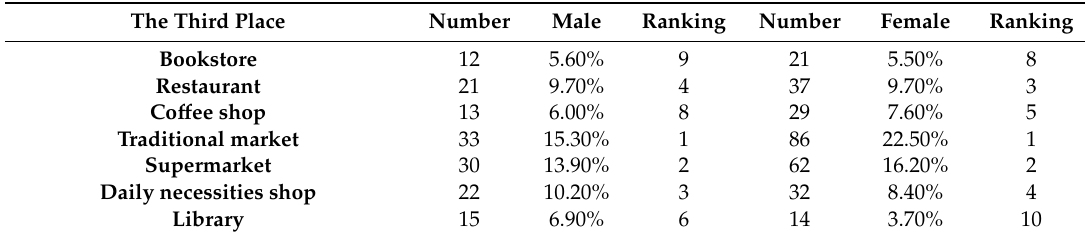
Table 4. The third places of seniors in